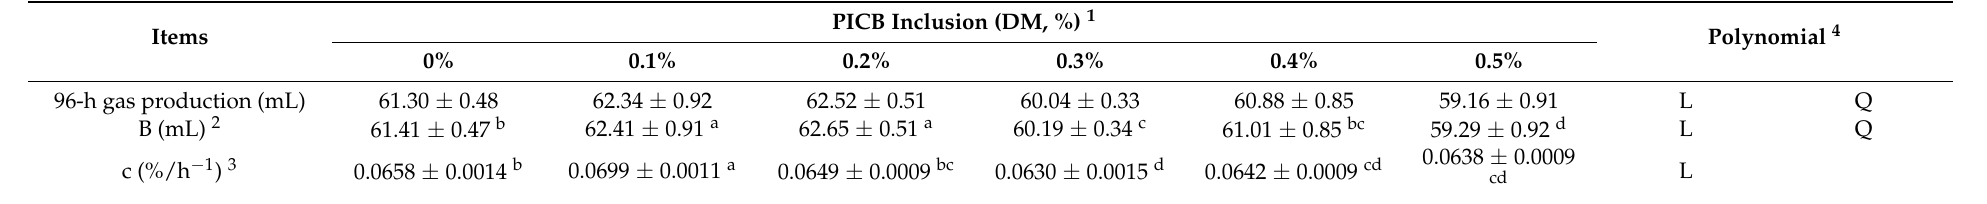
Table 4. Effect of different concentrations of PICB on in-vitro rumen fermentation 96-h dynamic fermentation